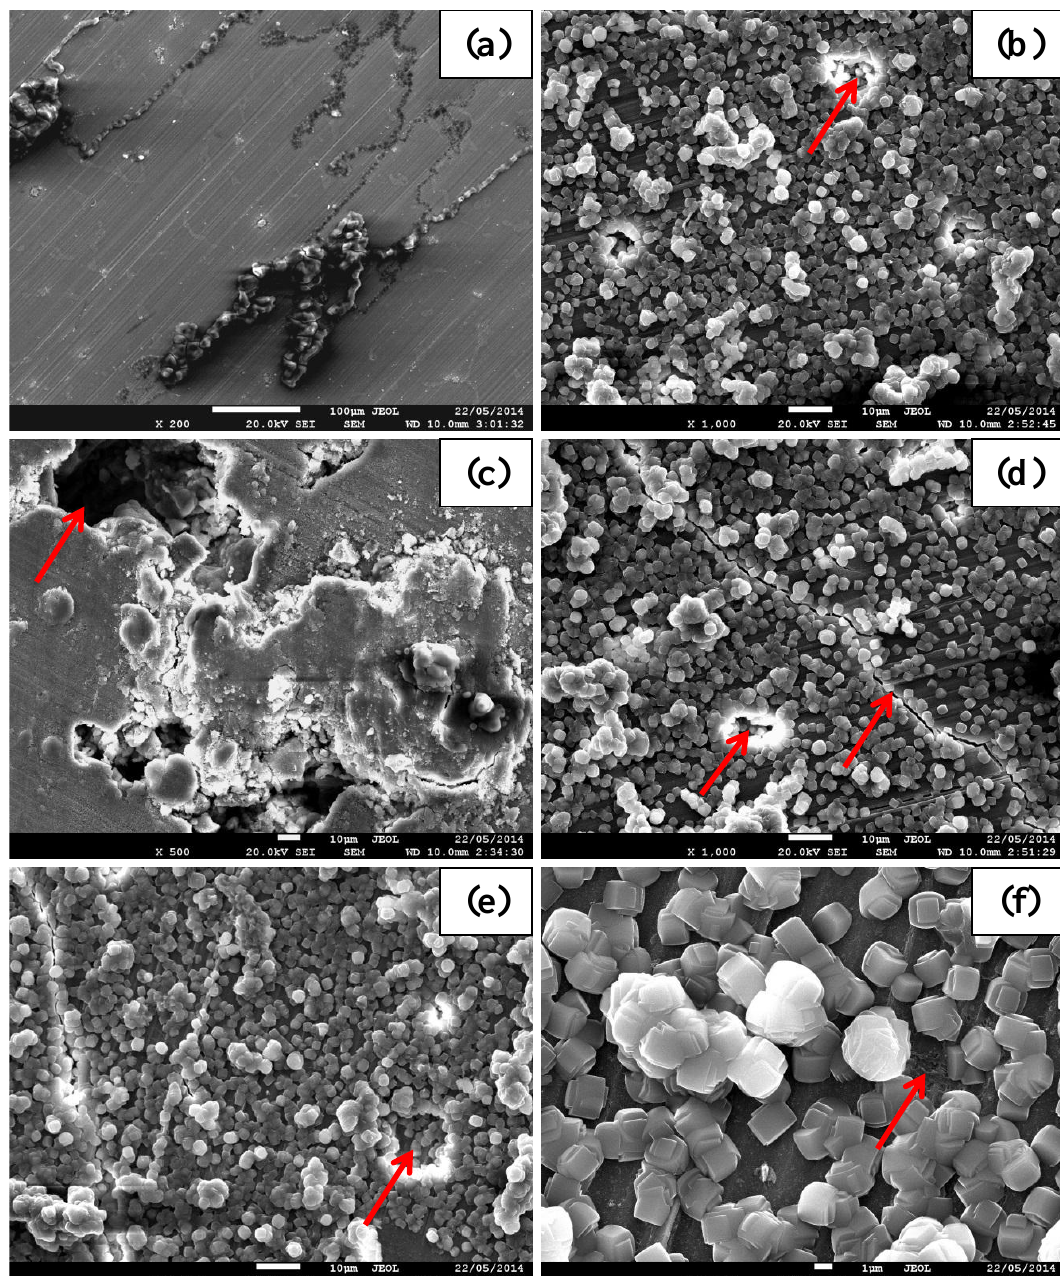
Figure 8. Scanning electron micrograph of the post corrosion morphologies of ( a ) uncoated and ( b ) zeolite coated specimens at 2 h of immersion. Corrosion morphologies of the ( c ) uncoated and ( d ) zeolite coated alloy at 24 h of immersion. Corrosion morphologies of ( e ) zeolite coated specimen at 168 h of immersion in 0.1 M NaCl solution and ( f ) magnified view of ( e